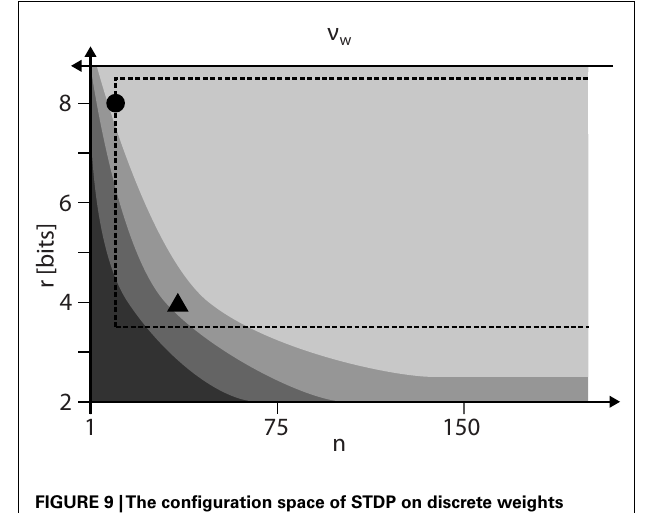
FIGURE 9 |The configuration space of STDP on discrete weights spanned by the weight resolution r and the number n of SSPs that is inversely proportional to the weight update frequency v w . The darkest gray area depicts the configurations with dead discrete weights ( Figure 3 ).The lower limits of configurations for proper equilibrium weight distributions ( Figure 4 ) and single synapse dynamics ( Figure 6 ) are shown with brighter shades.The dashed rectangle marks configurations realizable by the FACETS wafer-scale hardware system (assuming an acceleration factor of 10 3 , all synapses enabled for STDP and SSPs applied with 10Hz).The working points for a 4-bit ( n = 36) and 8-bit ( n = 12) weight resolution are highlighted as a triangle and circle,